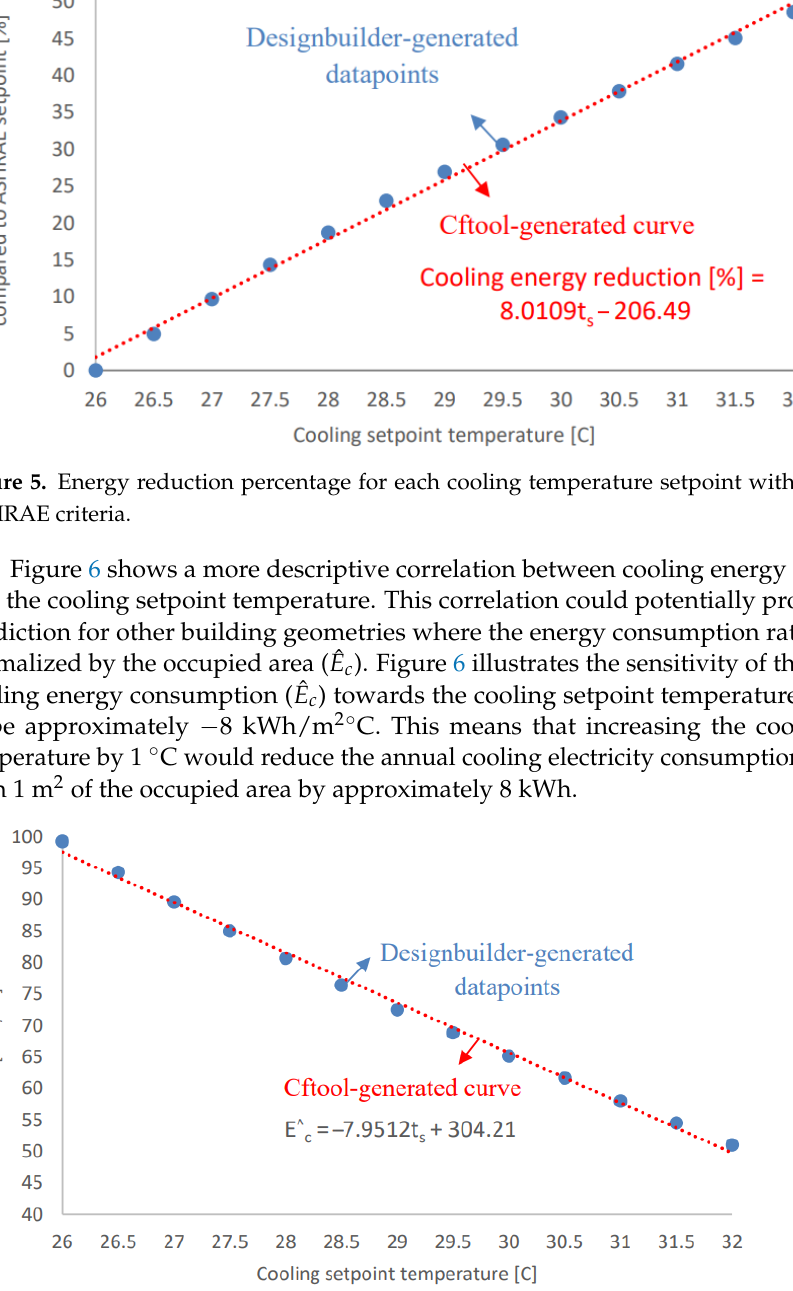
Figure 6. Normalized cooling energy consumption with respect to the cooling setpoint temperature.